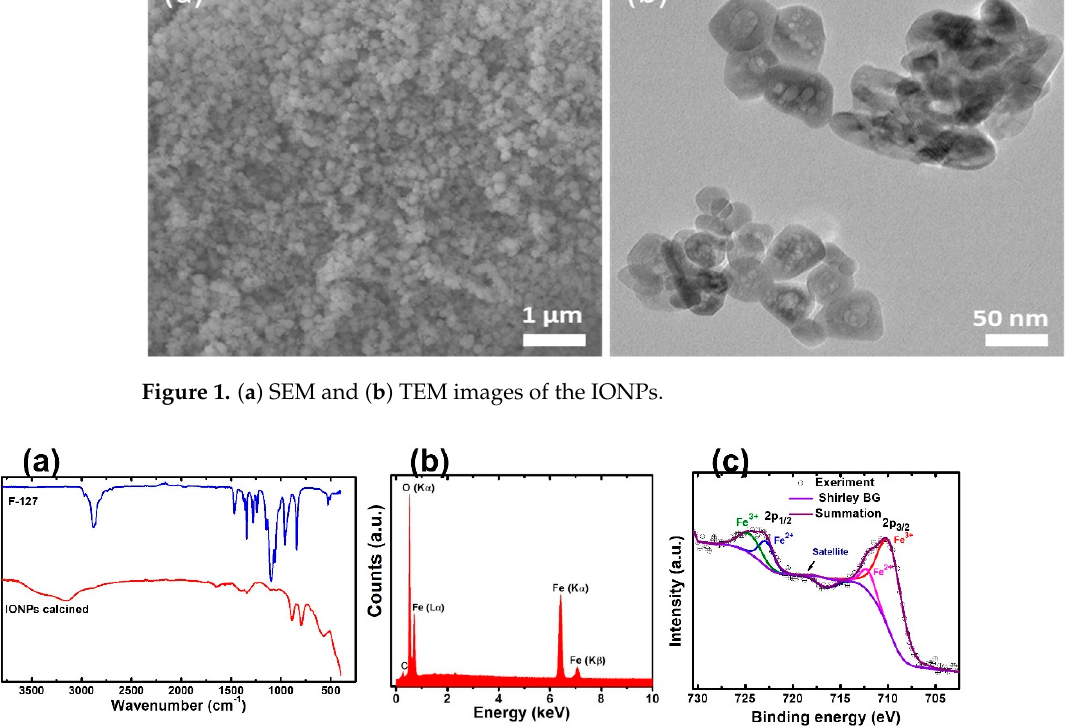
Figure 2. ( a ) FTIR spectra of polymer and IONPs. ( b ) EDX spectrum of IONPs. ( c ) XPS graph of Fe atoms showing the deconvolution at 2p 1/2 and 2p 3/2 .